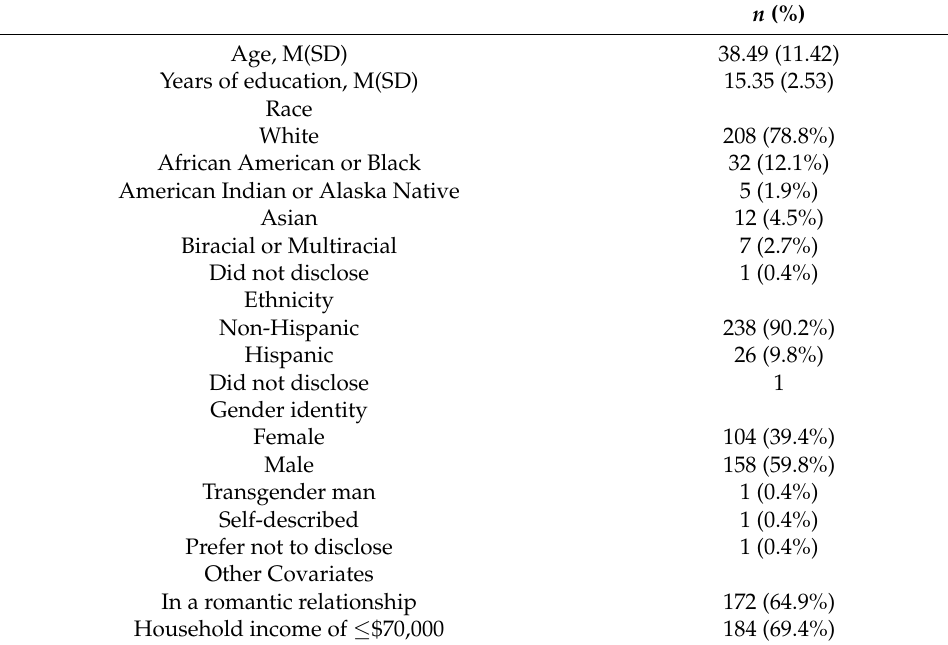
Table 1. Descriptive characteristics of the sample, n =